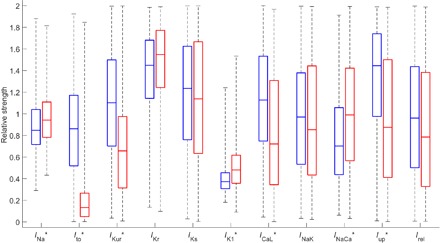
Accepted parameter values for the SR and cAF populations predict well the changes in ionic behavior associated with the cAF pathology.Box plot of θ values comprising the POMs calibrated to the SR (blue) and cAF (red) data sets. Values are expressed in relation to the base parameter values for the CRN model. Current densities that show statistically significant differences (P < 0.001 from the Mann-Whitney U test) are indicated with “*.” The currents most well known as remodeled in cAF (Ito, IKur, IK1, and ICaL) all show significant differences in the correct directions.